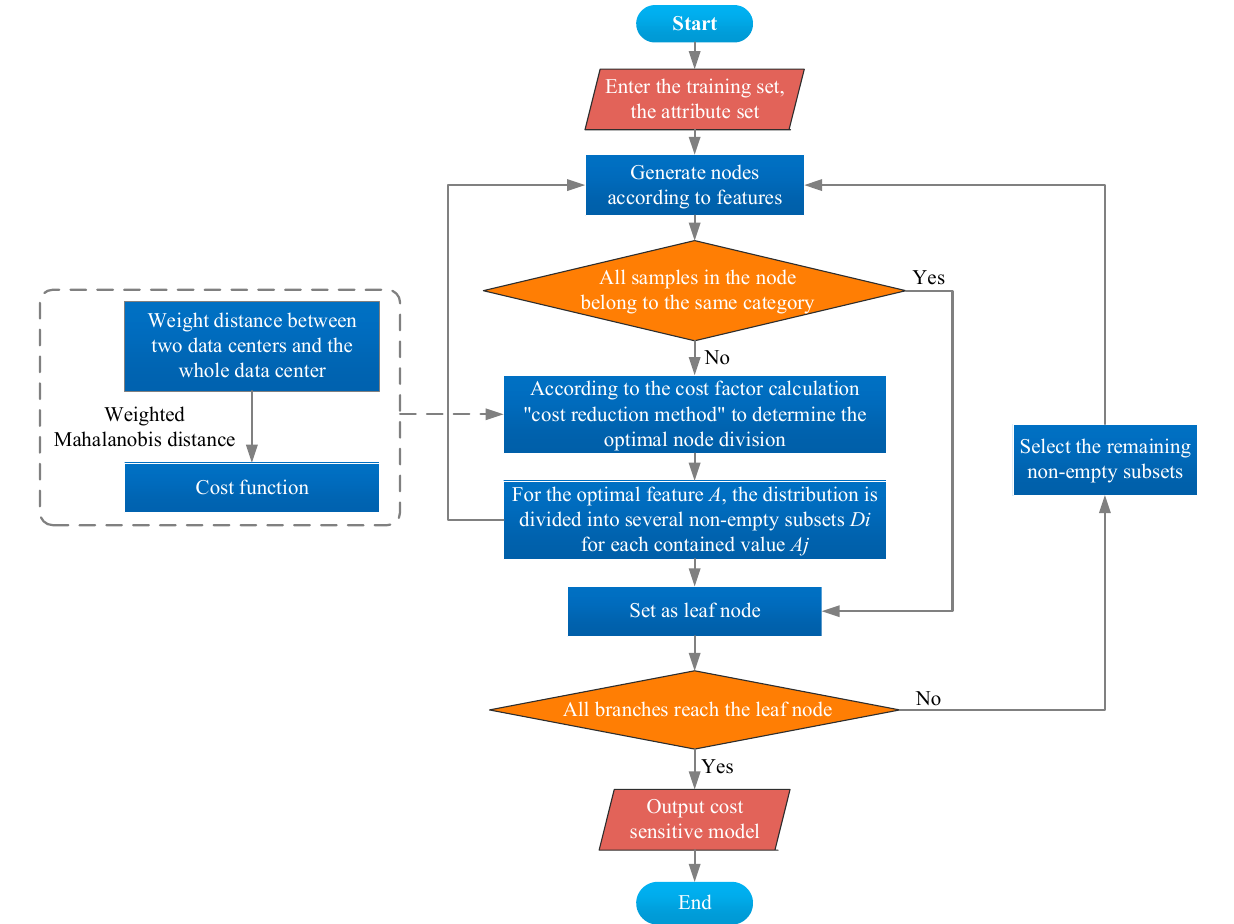
Figure 3. The flowchart of cost-sensitive random forest.